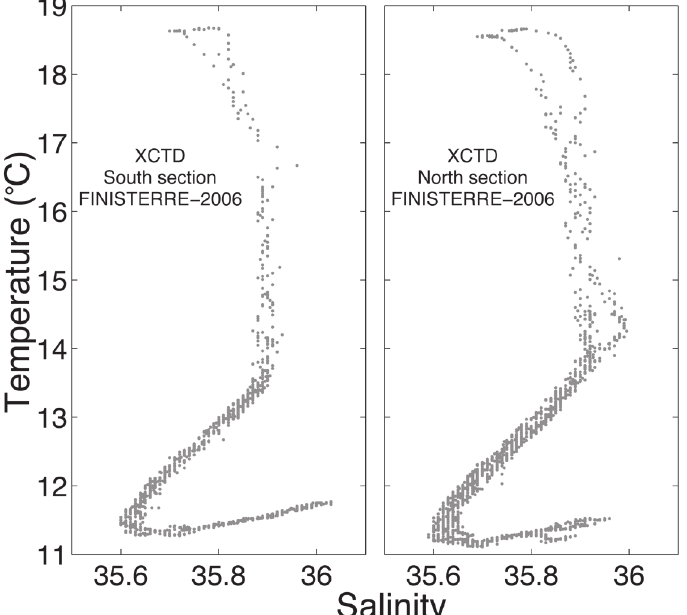
Fig . 13. – TS diagram corresponding to XCTD observations in the southern (left) and northern (right) sections during the FINISTERRE-2006